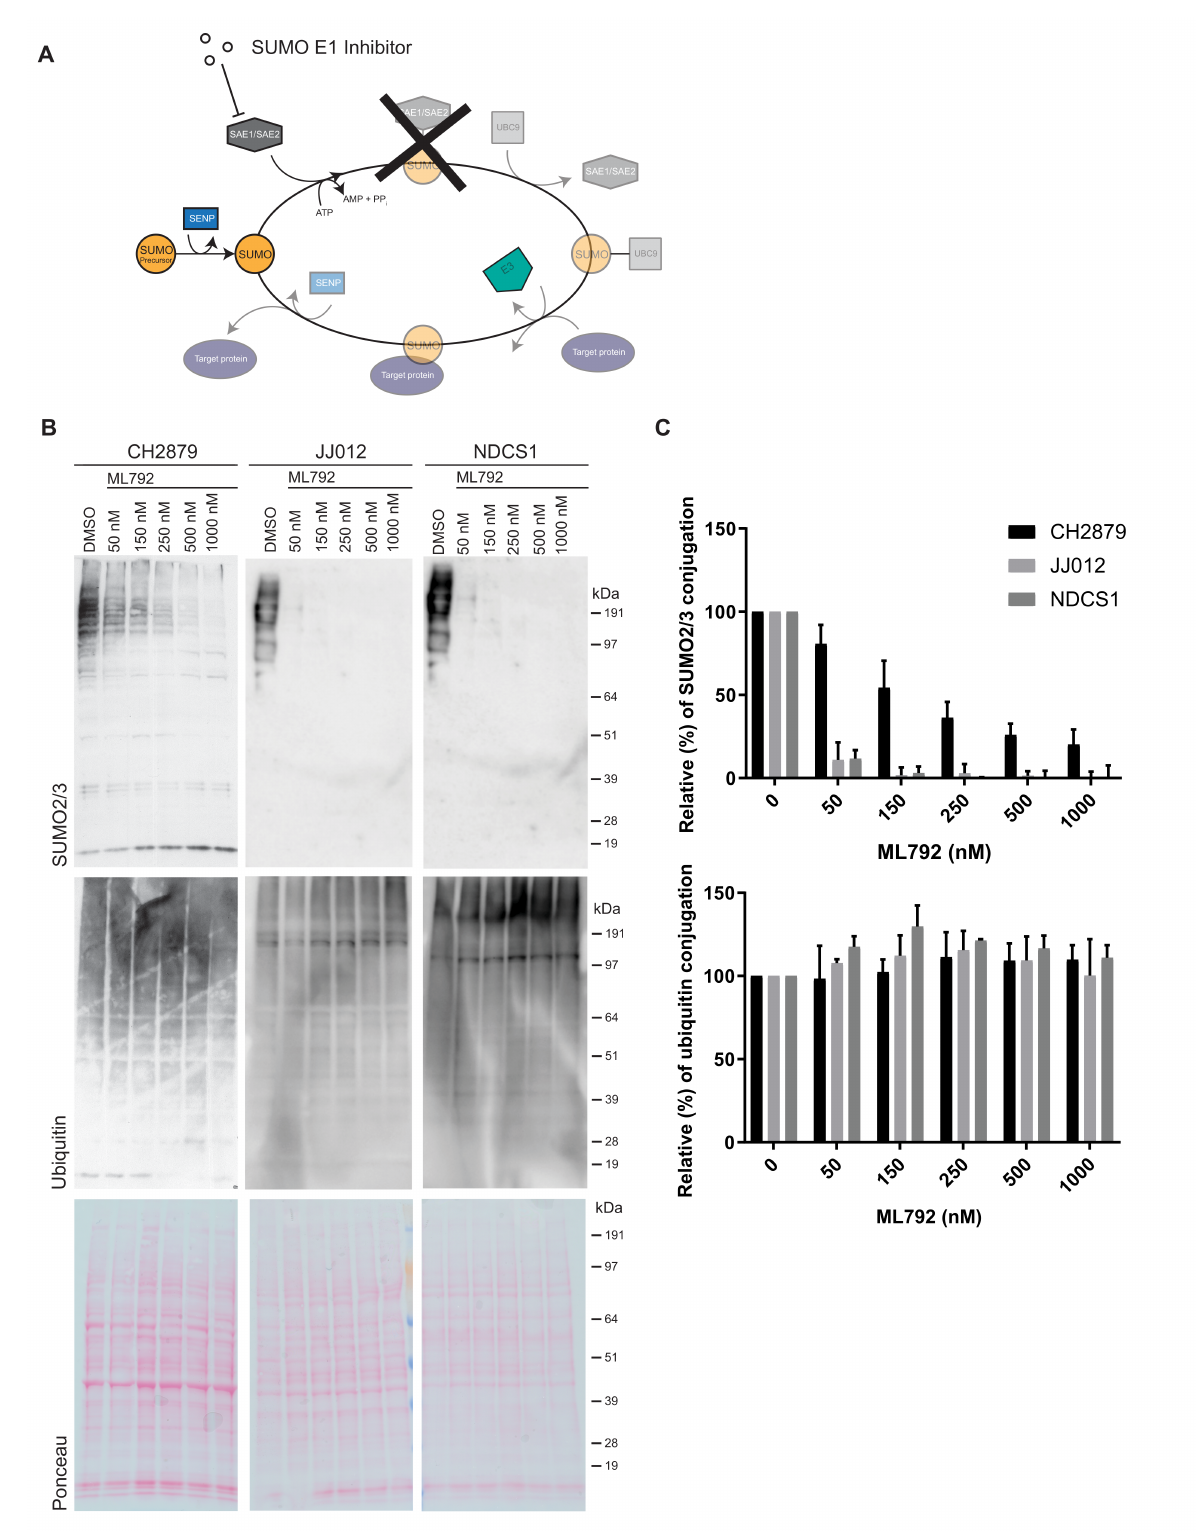
Figure 2. The SUMO E1 inhibitor ML792 blocks SUMO conjugation. ( A ) Cartoon of the function of the SUMO E1 inhibitor ML792. ( B ) Western blot analysis of SUMO2/3 and ubiquitin levels of the chondrosarcoma cell lines CH2879, JJ012, and NDCS1 treated with the indicated concentrations of the SUMO E1 inhibitor ML792 for 4 h compared to solvent control (DMSO 0.1%). Ponceau S staining was used as loading control. ( C ) Quantitative analysis of SUMO2/3 and ubiquitin conjugation of the corresponding western blots shown in B. Data represent mean with standard deviation ( n =